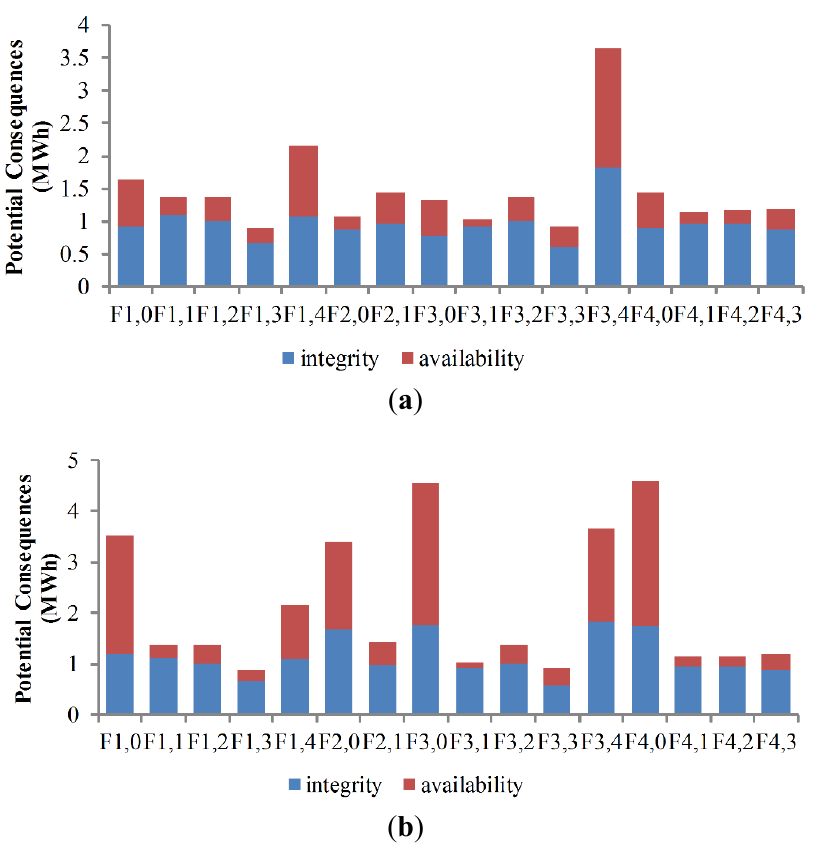
Figure 5. ( a ) Physical consequences of attacking FRTUs in Scheme 1; ( b ) Physical consequences of attacking FRTUs in Scheme